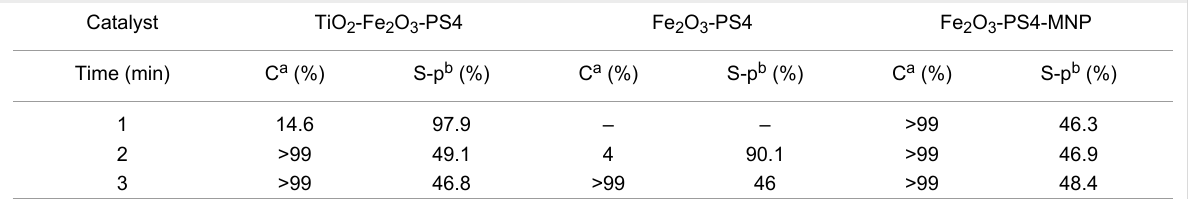
Table 6: Conversion and selectivity of the microwave-assisted alkylation of toluene for the three catalytic systems.